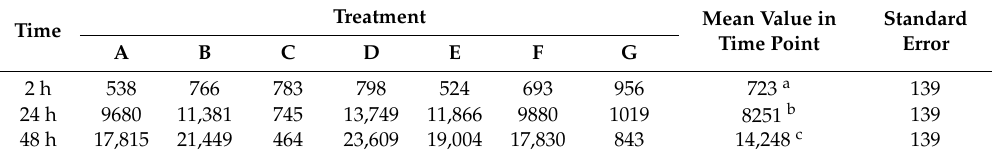
Table 2. The mean viability level of cardiac progenitor cells (CPC) culture in timepoints. (A) control culture; (B) culture with 2 μ g/mL AgNP; (C) culture with 10 μ g/mL AgNP; (D) culture with 0.4 μ g/mL HNC; (E) culture with 2 μ g/mL HNC; (F) culture with 2 μ g/mL AgNP and 0.4 μ g/mL HNC; (G) culture with 10 μ g/mL AgNP and 2 μ g/mL HNC. a–c Statistically significant differences ( p < 0.0001). All the data presented as mean fluorescence intensity (MFI).